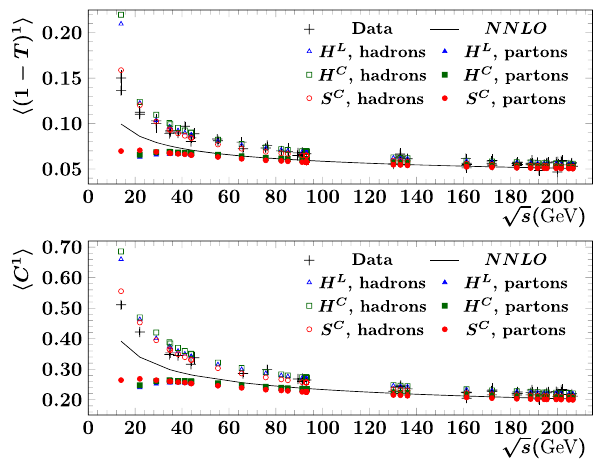
Fig. 1 Data and predictions by MCEGs extrapolated to Q 0 = 0GeV. The NNLO result was computed using α S ( M Z ) = 0 . 118